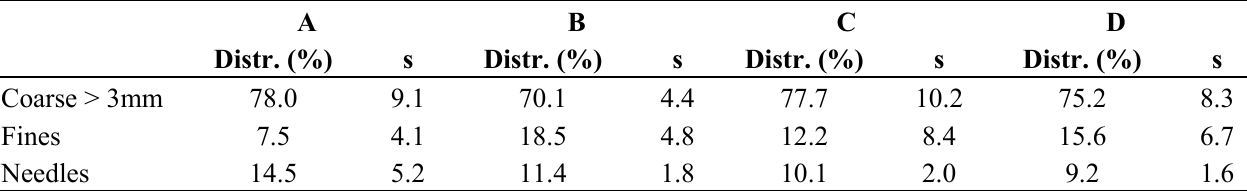
Table 4. The mean content (%) and standard deviation (s) of indicated fractions in the four types of samples of logging residues: A, fresh material in April (TR2); B, the dried-stacked material at the time of forwarding to the roadside windrow in September (TR3); C and D, the fresh- and dried-stacked material when delivered after chipping in November (TR5),